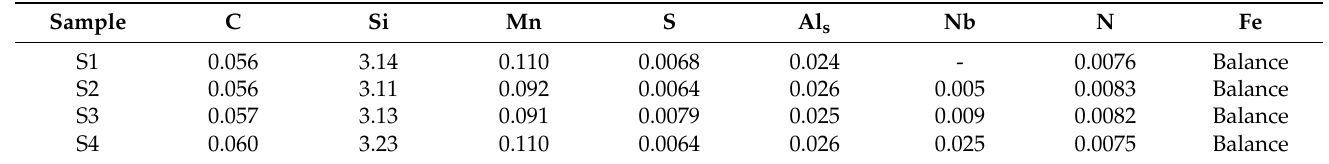
Table 1. Chemical compositions of tested silicon steel